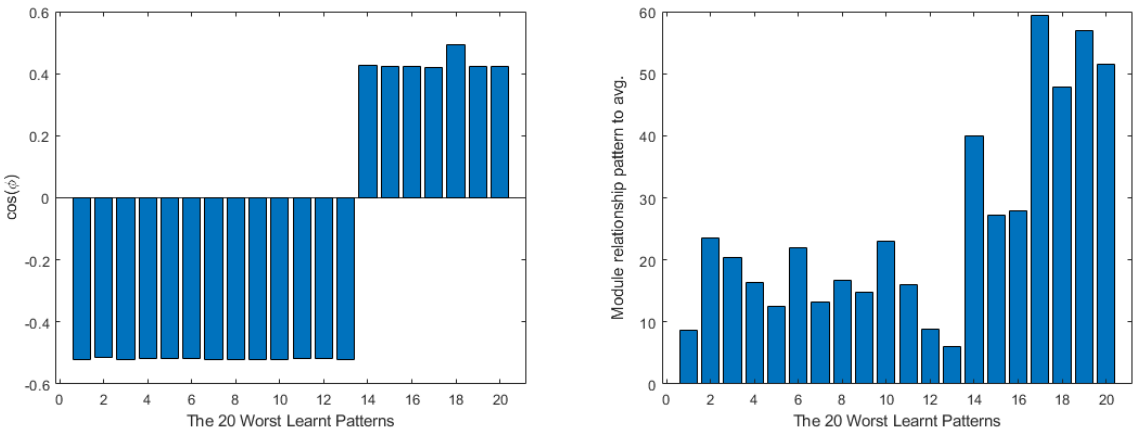
(cid:12) (cid:12) 𝜕𝐿𝑜𝑠𝑠 ∂ Loss (cid:12) (cid:12) | relationship to the average (cid:12) (cid:12) relationship to the average ∂ W n 𝜕𝑊 𝑛